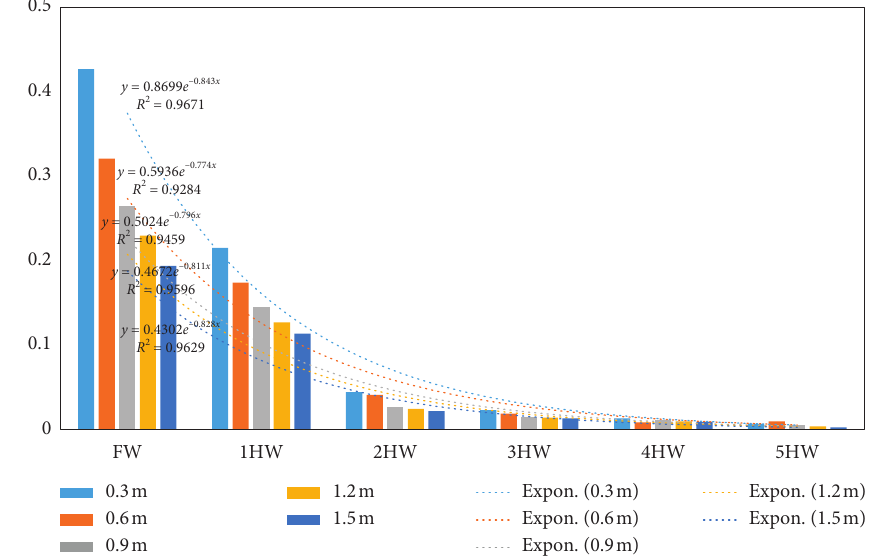
Figure 20: Concrete functional relationship among different amplitudes of